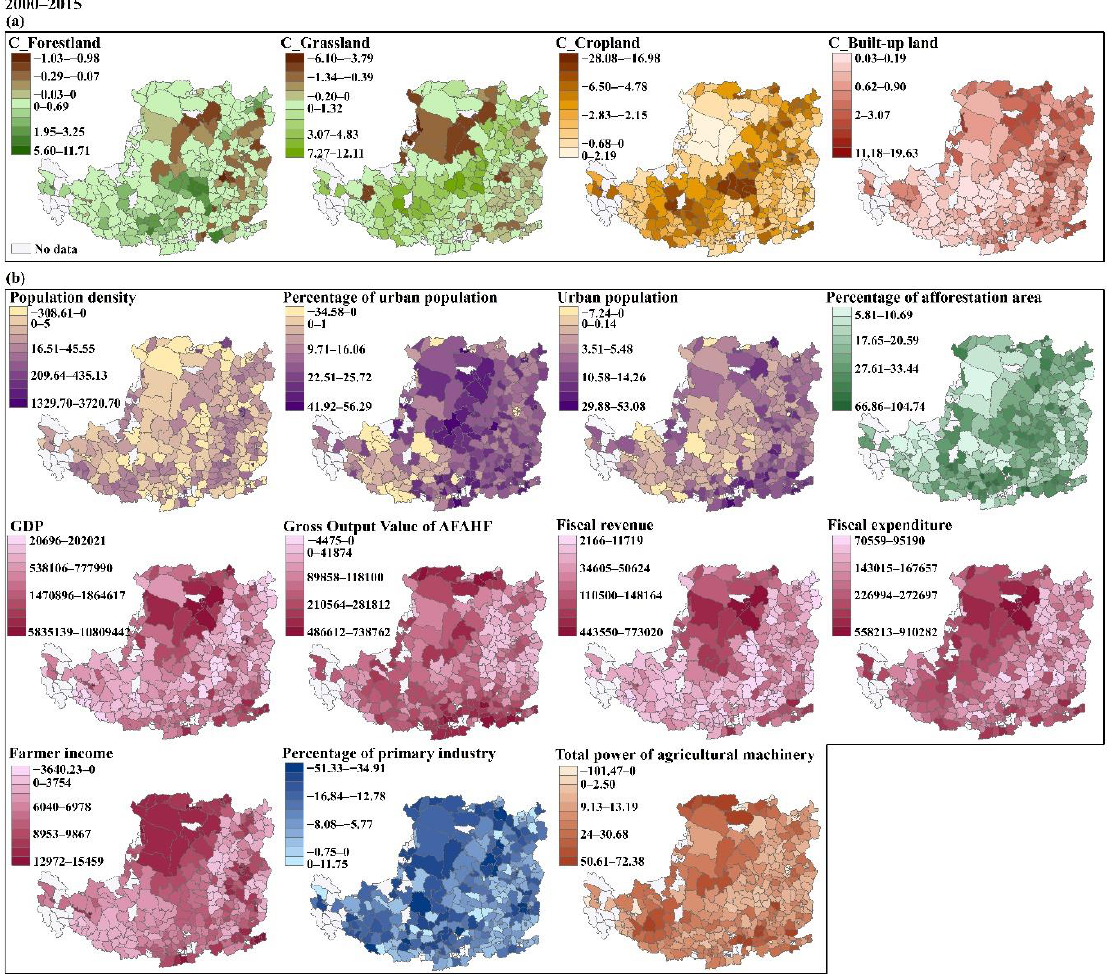
Figure 9. Changes of four dominant land-use types ( a ) and the socioeconomic factors ( b ) from 2000 to 2015.